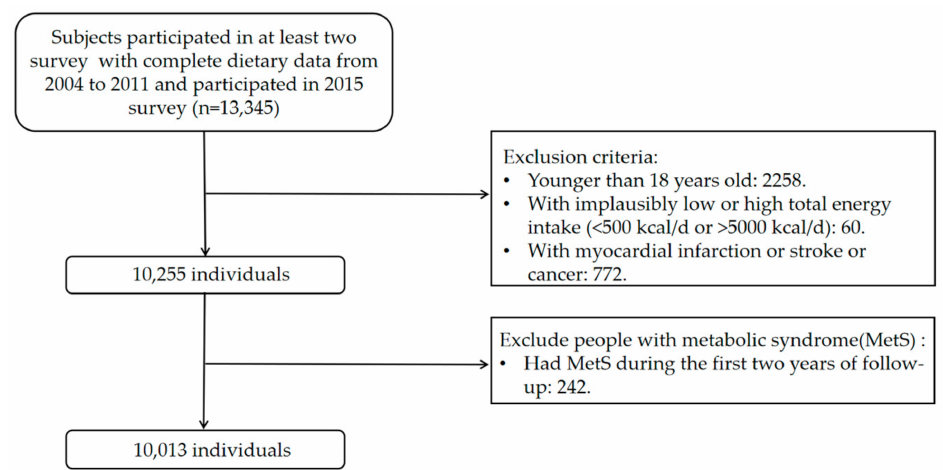
Figure 1. Flow chart of the subject-selection